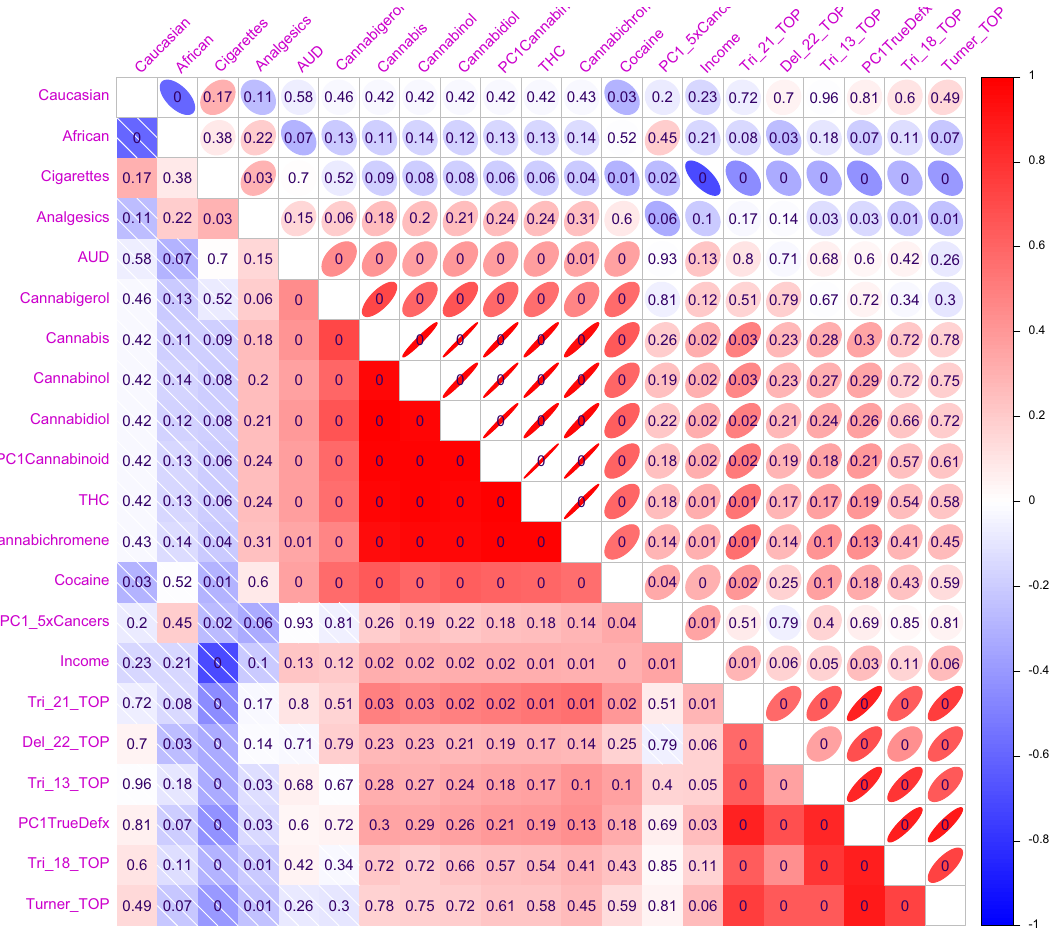
Figure 8. Correlogram drawn in Corrplot for the significance of correlative relationships between covariates for ETOPFA-corrected data. Numbers represent the P-values corresponding to the Pearson correlation coefficients. The colouring is scaled from strongly positive (bright red) to strongly negative (bright royal blue). The upper triangle represents these associations as ellipses where the width of the ellipses in inversely proportional to the strength of the correlation so that the strongest associations have the narrowest ellipses. Ellipses slope to the right for positive relationships and to the left for negative relationships. (Created in R-Studio version 1.3.1093 using corrplot version